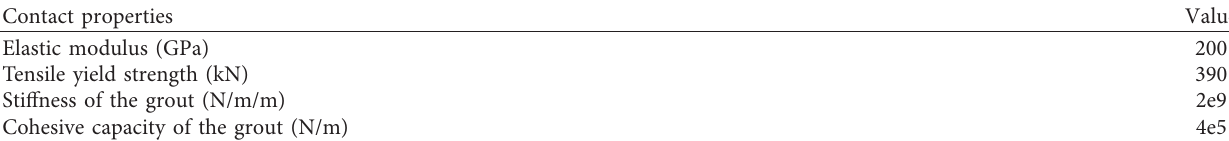
Table 4: Properties of support elements in